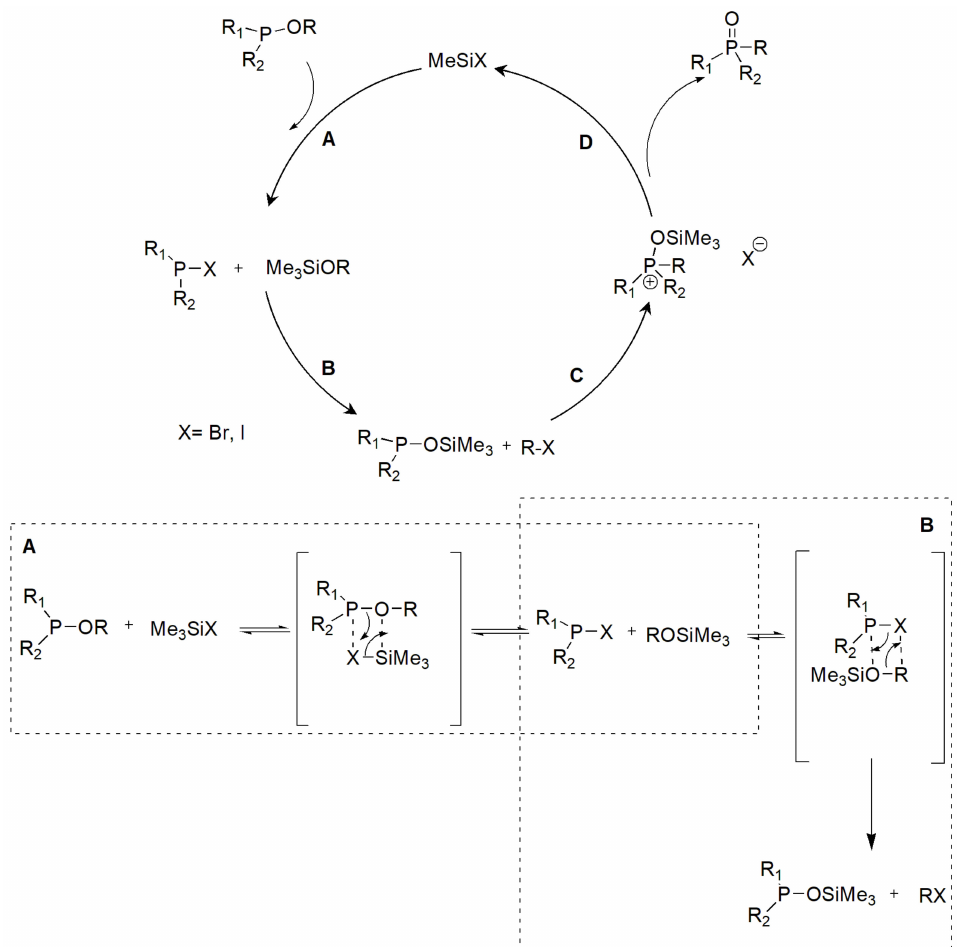
Scheme 21. The catalytic cycle of the reaction ( upper ) and the mechanisms for the first and second step of the cycle ( lower